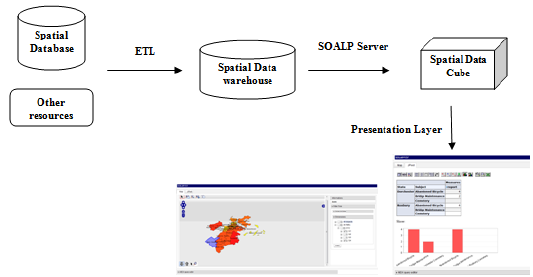
Figure 4. Architecture of the developed SOLAP system